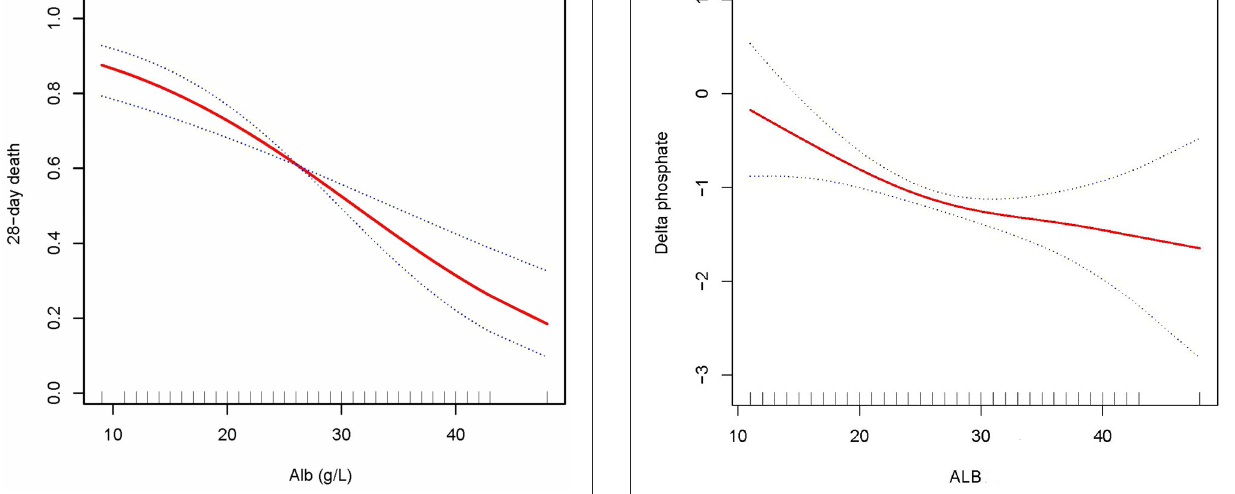
FIGURE 2 | Adjusted smoothing function of ALB for 28-day mortality. After adjusting for age, gender, body mass index (BMI), Charlson comorbidity index (CCI score), C-reactive protein (CRP), white blood cell (WBC), hemoglobin (HB), phosphate (0h), K + , HCO 3 − , acute kidney injury (AKI) cause, continuous renal replacement therapy (CRRT) cause, (acute kidney injury network (AKIN) stages, CRRT dose, 2h urine output before CRRT initiation, and sequential organ failure assessment (SOFA) score, curve fitting analysis showed that the 28-day mortality rate decreased as the ALB increased.